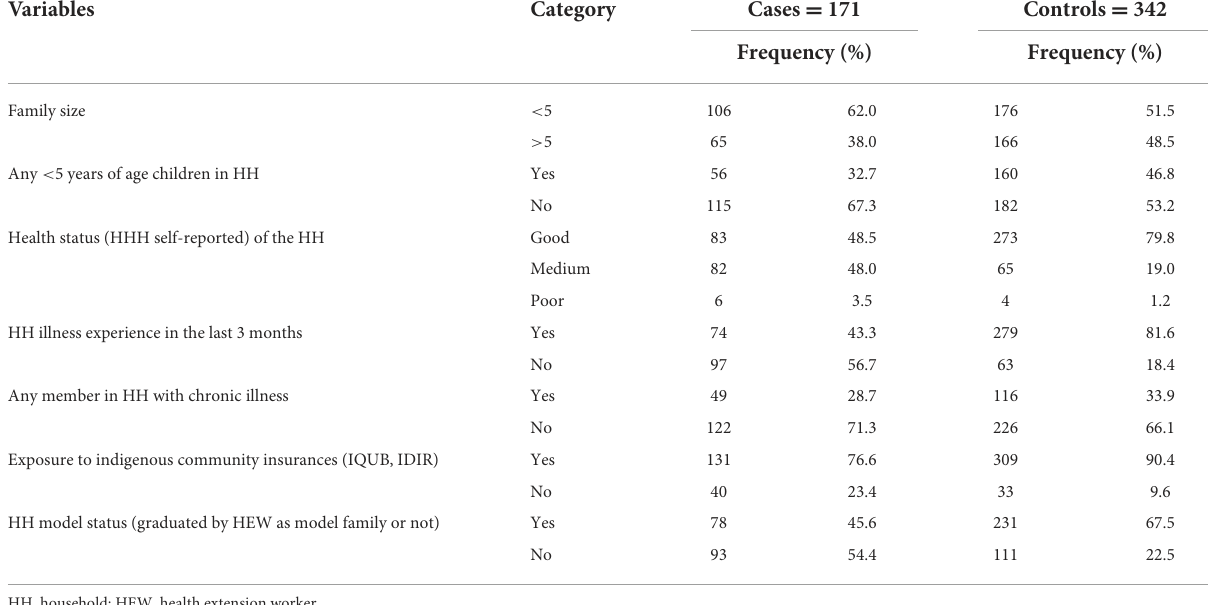
TABLE 2 Household-related characteristics of the cases and controls of factors influencing dropout of HH from CBHI membership in rural districts of the Gurage Zone, southern Ethiopia, 2021 ( n = 513). Variables Category